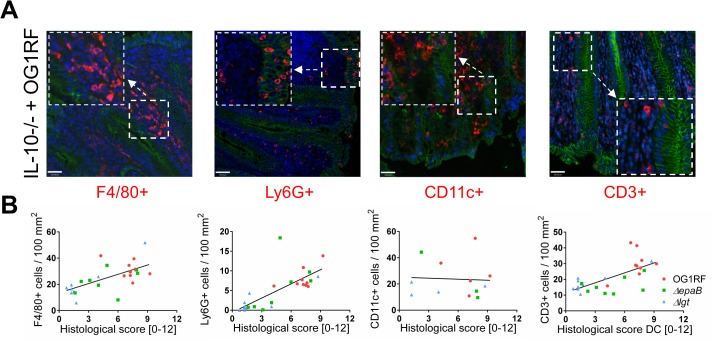
Colitogenic activity of E. faecalis is associated with infiltration of different immune cell subsets in monoassociated IL-10-/- mice.(A) Representative images of distal colon sections from IL-10-/- mice monoassociated with E. faecalis OG1RF stained by immunofluorescence for F4/80+ (red), Ly6G+ (red), CD11c+ (red) or CD3+ (red) cells, E-cadherin (intracellular domain, green), nuclei (blue) and magnifications of respective images as indicated by white frames (scale bar = 100μm). (B) Relationship between F4/80+, Ly6G+, CD11c+ or CD3+ cells infiltrating the distal colon of monoassociated IL-10-/- mice with respective histological scoring for distal colon was assessed by Pearson correlation coefficient test (F4/80+ cells: Pearson r = 0.6460, ***p<0.001; Ly6G+ cells: Pearson r = 0.7382, ****p<0.0001; CD11c+ cells: Pearson r = -0.05360, p>0.05; CD3+ cells: Pearson r = 0.6661, ***p<0.001).